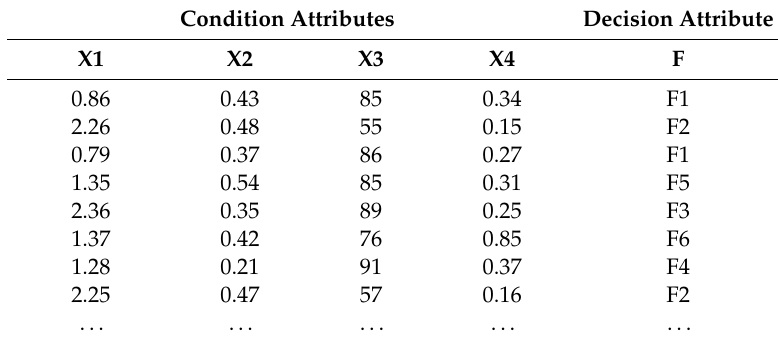
Table 6. Partial fault data set.